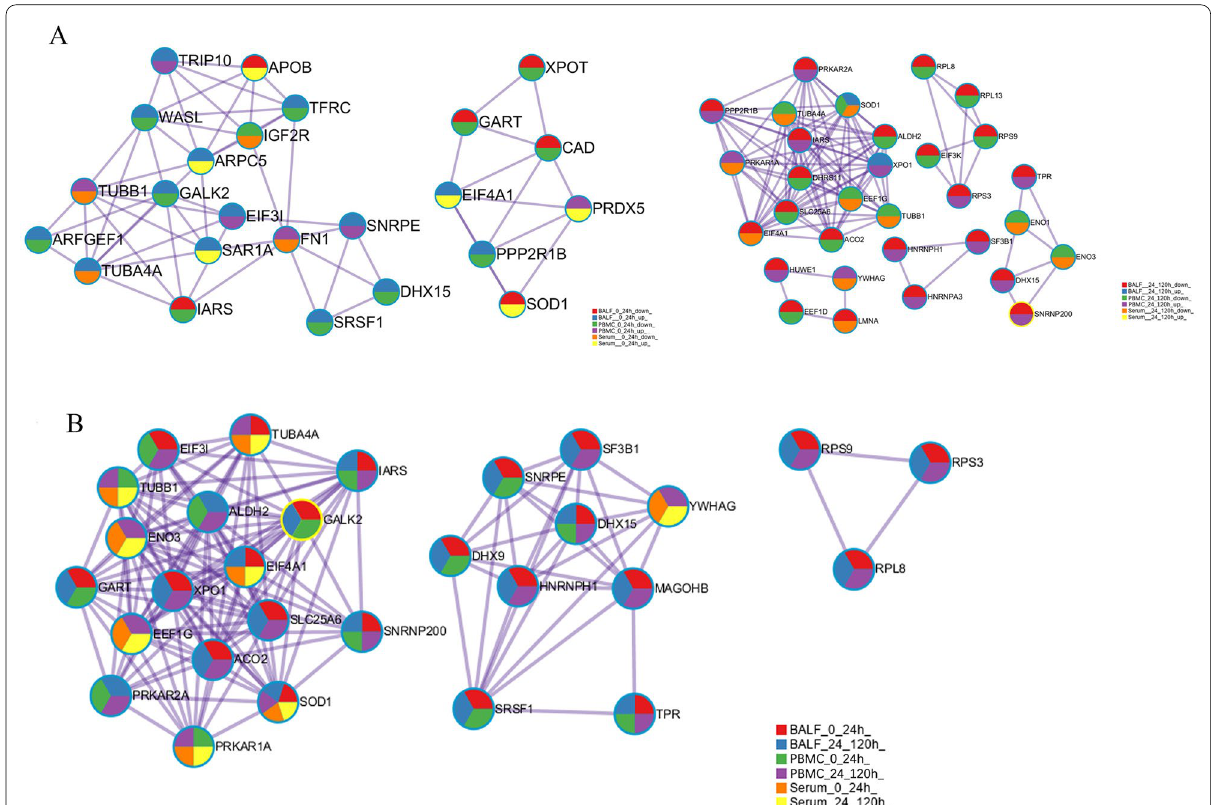
Fig. 5 Metascape analysis of the interactions between common DEMs involved in APP infection. A Network nodes from up-/down-regulation of DEMs were displayed as pies. B Network nodes from different infection stages (0–24 h, 24–120 h) are displayed as pies. Color code for pie sector represents a gene group from which the gene is derived and is consistent with the colors used for